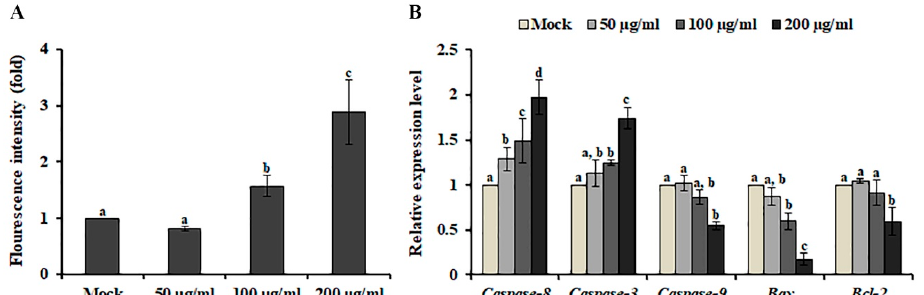
Figure 3. Effect of Abeliophyllum distichum leaves extract on caspase-3 activity and gene expression in SK-MEL-2 cells. The activity of caspase-3 ( A ) and expression of genes involved in the extrinsic and intrinsic apoptotic pathways ( B ) were analyzed after AL treatment for 48 h. The transcript level of each gene was normalized to the constitutive expression level of GAPDH and was expressed relative to the values of the mock-treated control. Data represent the means ± SE of three independent experiments. Different superscript letters represent significant differences compared with the mock- treated control ( p < 0.05).